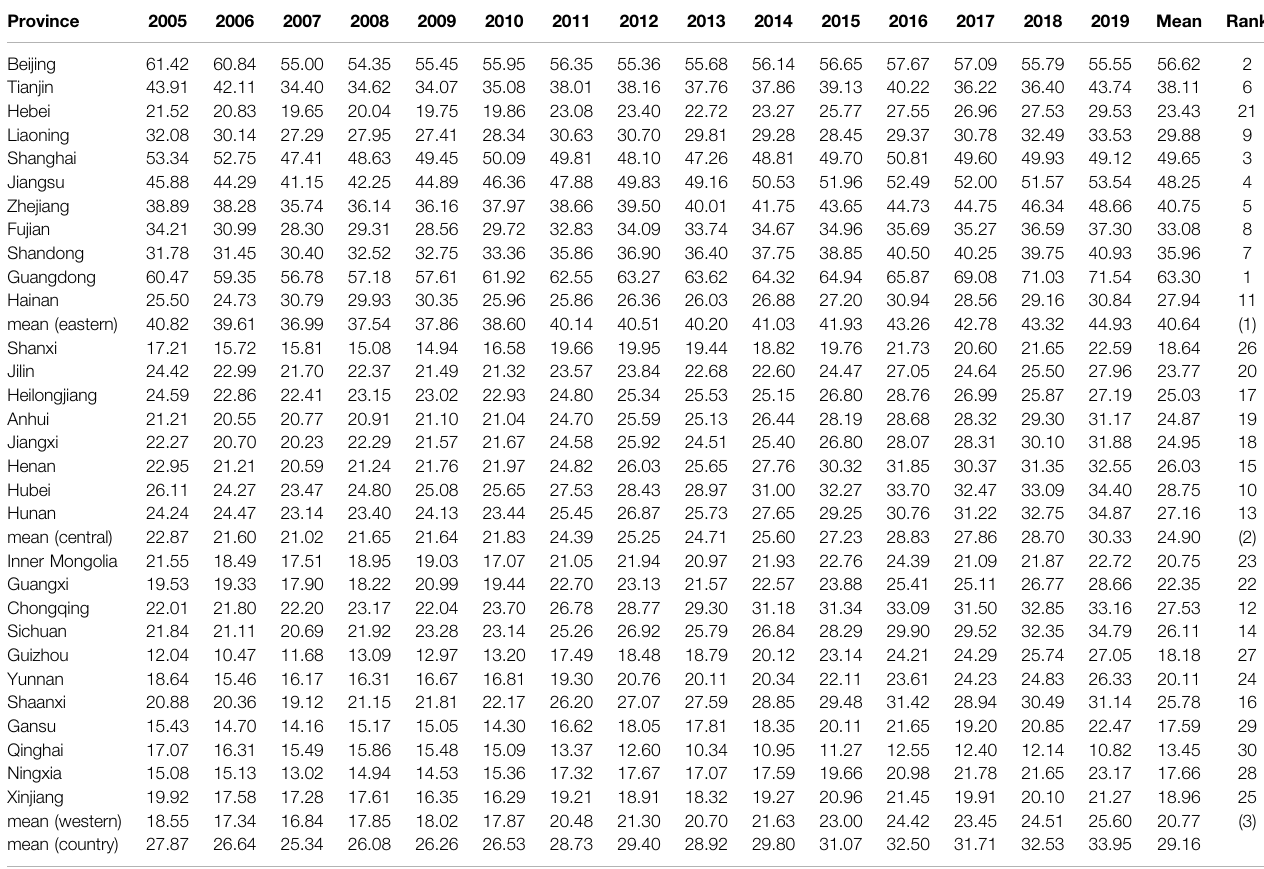
TABLE 2 | Regional HQED index of China from 2005 to